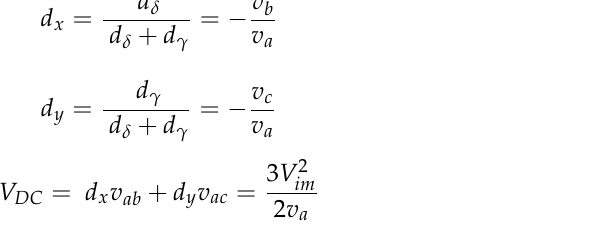
Table 1. The DC-link voltage, duty cycles, and switching states for every sector’s rectifier.